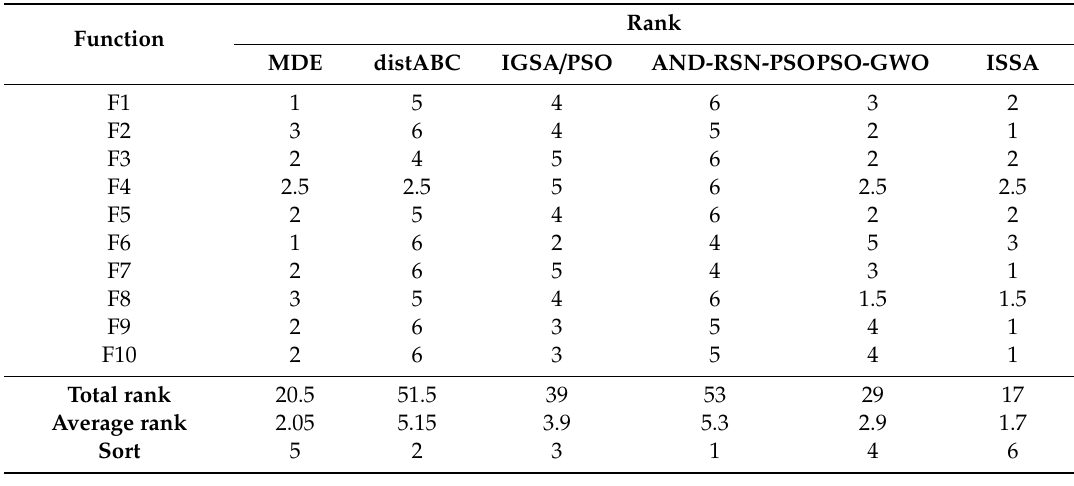
Table 9. The results of the Friedman test.